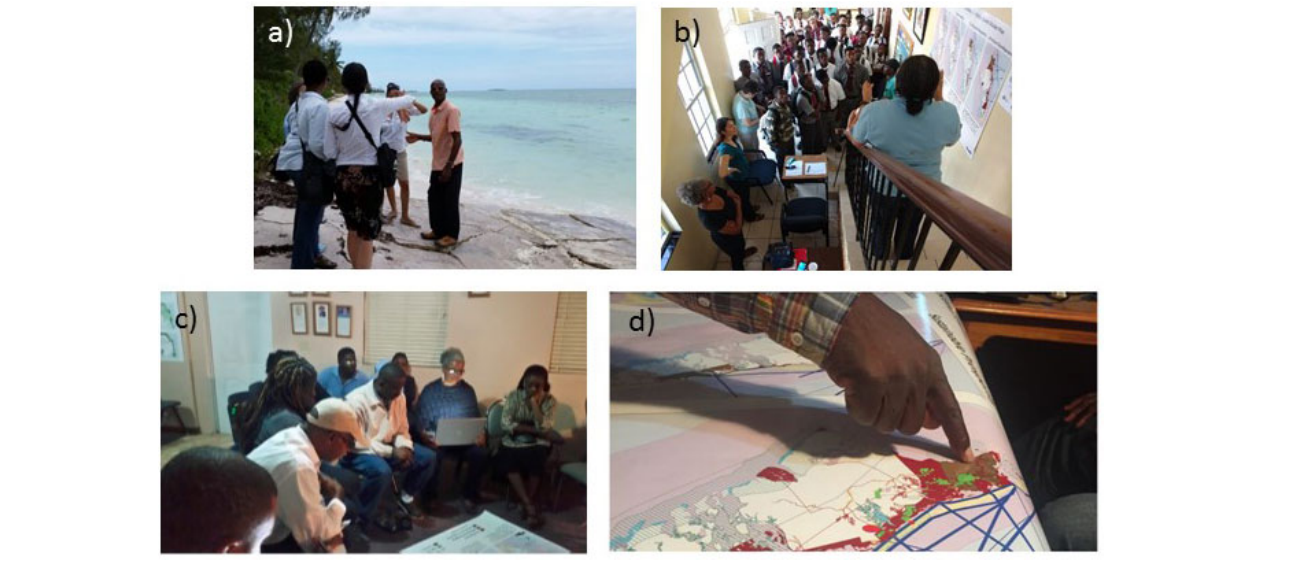
Fig. 3 . The project partners met with stakeholders in the field (a) and in meeting halls (b, c) across Andros throughout the two-year planning process. In the initial phases these conversations focused on understanding the socio-cultural landscape and broad ideas about the future, i.e., visions and values. In addition, stakeholders brought up the most important habitats and human activities on the island. Later conversations included feedback on mapped human activities and habitat risk